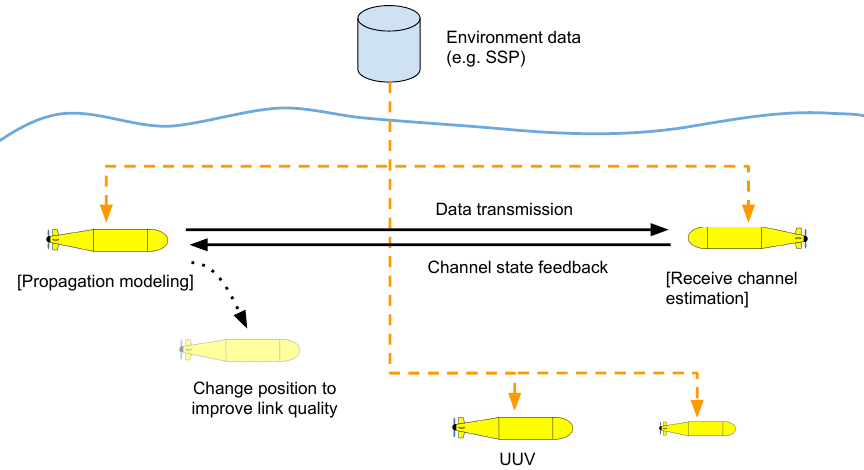
Figure 5. Autonomous node mobility to improve the quality of UWA communication based on: (1) internal propagation modelling, (2) channel estimation, (3) channel state feedback from the